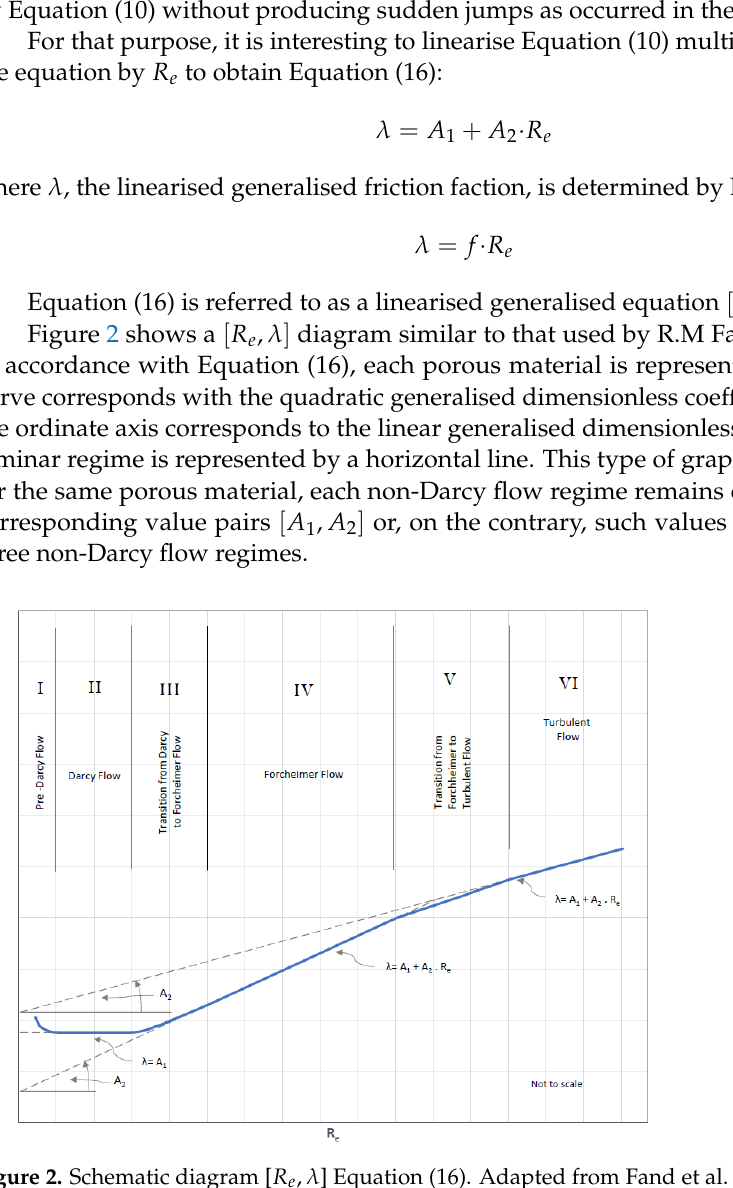
Figure 2. Schematic diagram [ 𝑅 𝑒 ,𝜆 Equation (16). Adapted from Fand et al. (1987) [30] .